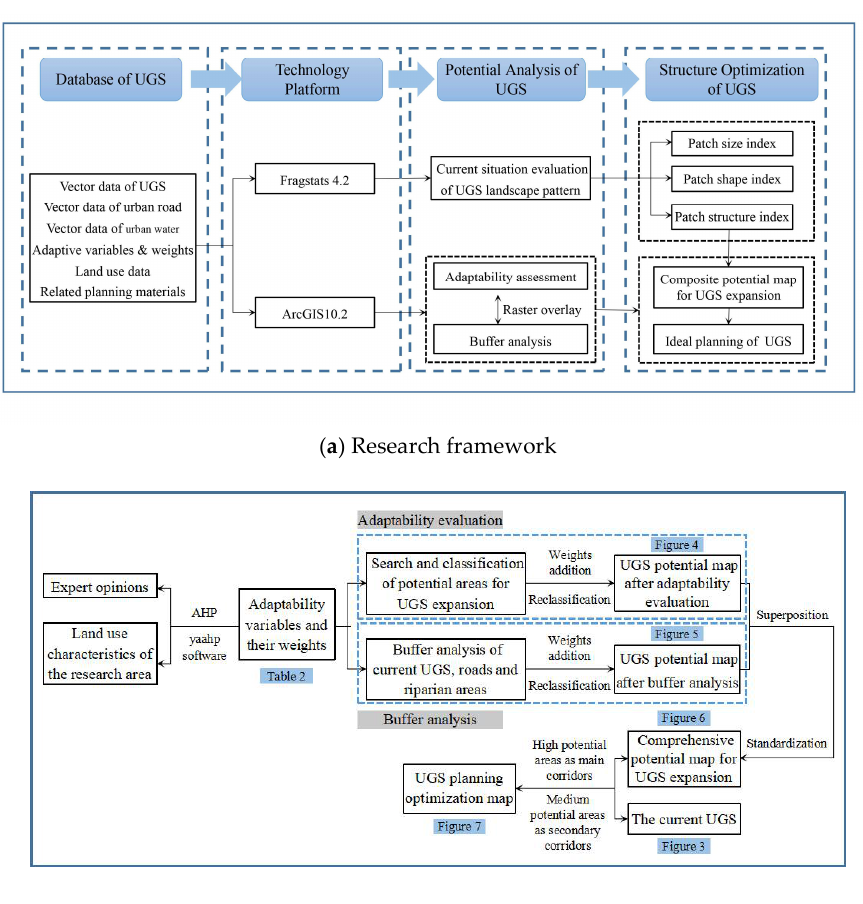
Figure 2. The research technical route. ( a ) The research framework explains the data type, technical platform and overall structure of the paper; ( b ) The evaluation method shows the specific operation methods and steps to determine the potential UGS.